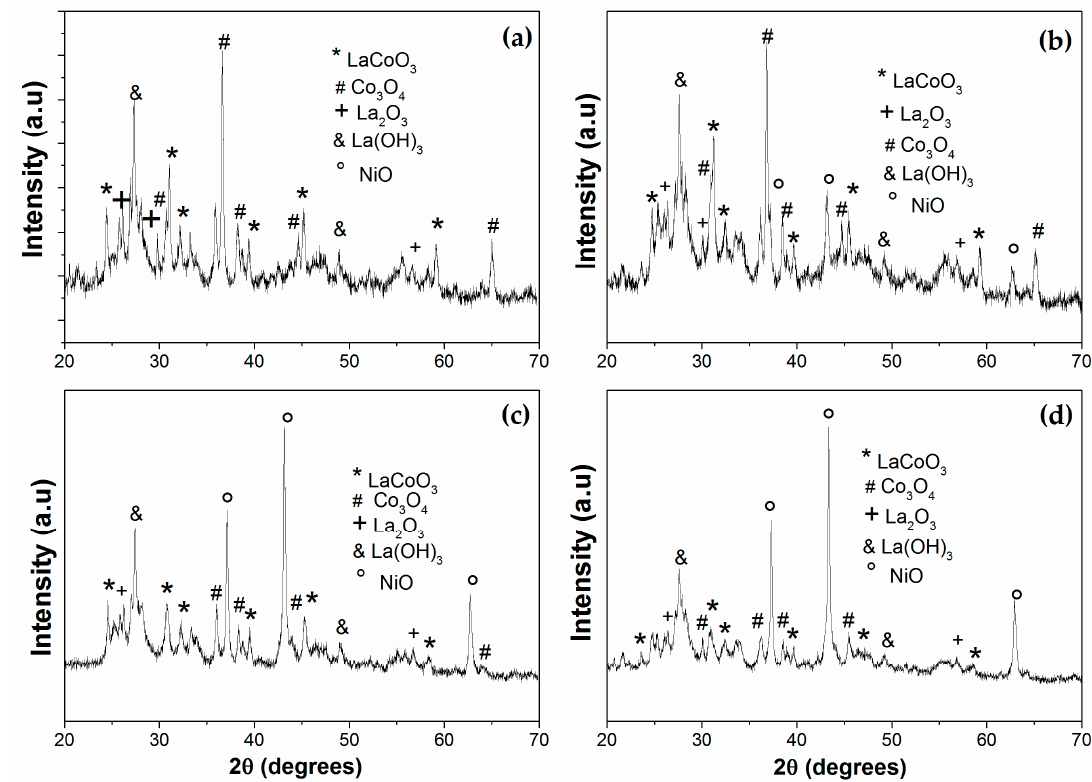
Figure 1. X-ray diffraction patterns of calcined catalysts: ( a ) Co/La 0.8 Ce 0.2 ; ( b ) Ni 0.1 Co 0.9 /La 0.8 Ce 0.2 ; ( c ) Ni 0.4 Co 0.6 /La 0.8 Ce 0.2 ; and ( d ) Ni 0.7 Co 0.3 /La 0.8 Ce 0.2.